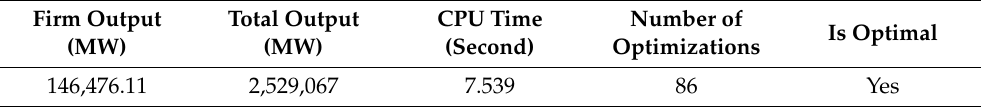
Table 5. The performances in solving the model.